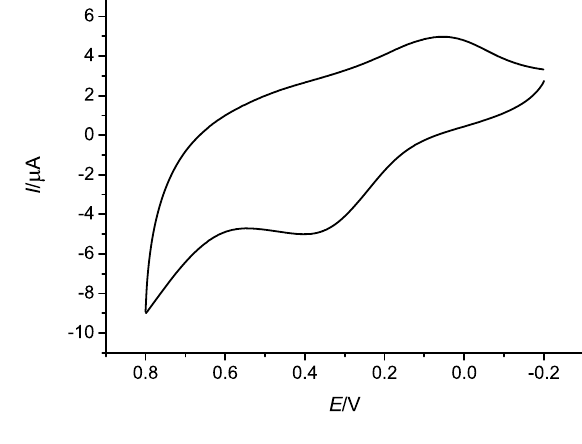
Figure 9. Cyclic voltammograms of complex 1 measured at room